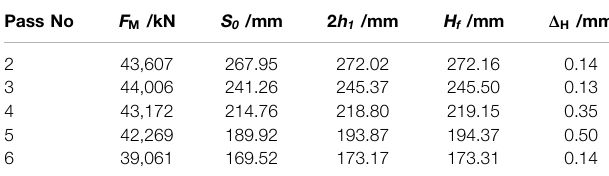
TABLE 2 | Comparison of the predicted outlet thickness with the measured